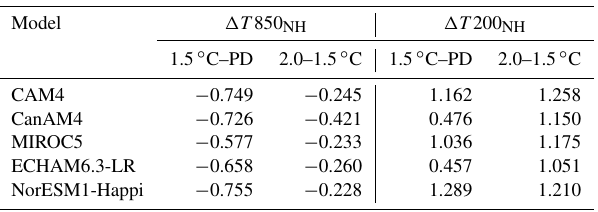
Table 3. Median responses from individual models of the equator- to-pole temperature contrast ( ◦ C) in winter at 850 and 200hPa for the Northern Hemisphere only. Positive values indicate a stronger contrast between the warm tropical atmosphere and cold polar at- mosphere with warming. See the caption of Fig. 11 for definitions of the temperature contrasts.